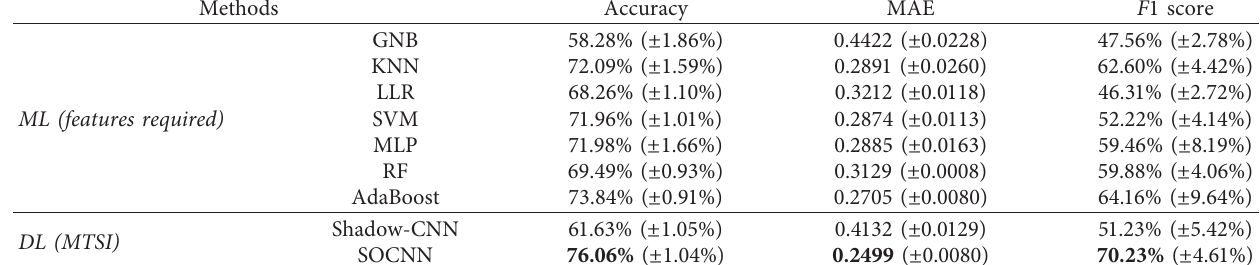
Table 3: Evaluation performance of different methods.